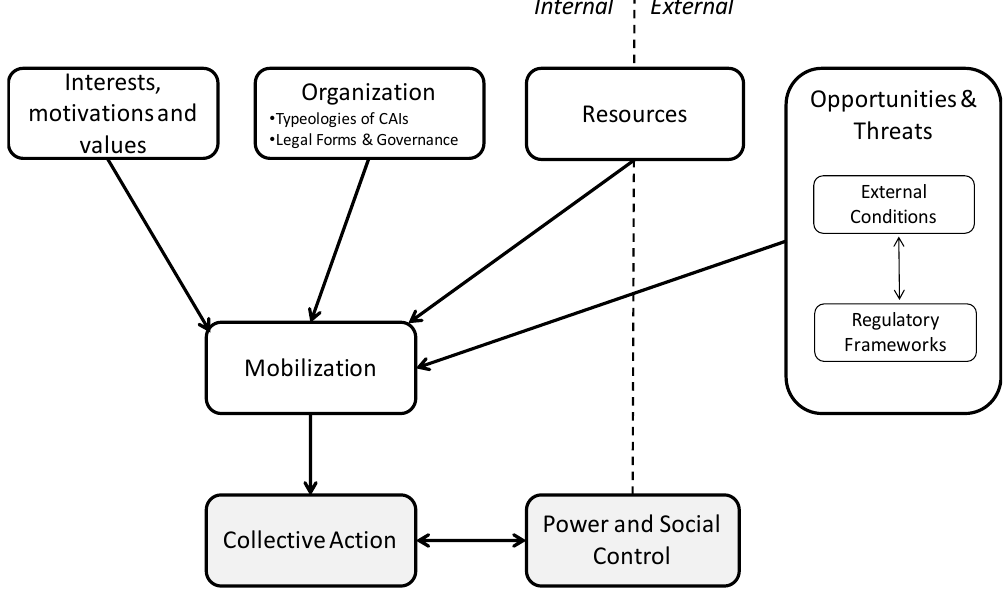
Figure 1. The Mobilization Model, inspired by Tilly [14]. Tilly [14] created a general mobilization model for all forms of collective action from worker strikes to large scale political revolutions. We simplify the model in order to apply it to CAIs in the energy sector. Whereas Tilly [14] describes dimensions of repression and facilitation, we divide this into the two components of external conditions and the regulatory framework, and place this under the opportunities and threats in the external domain. Resources are also not explicitly a component in Tilly’s [14] mobilization model, but are an important factor in energy CAIs and this dimension straddles both internal and external domains. Power is also more narrowly defined here than in Tilly’s [14] model (which can be applied from striking unions to political revolutions). An energy collective seeks only control over its local energy system with the goal of attaining social benefits that come with this action (e.g., stability, cohesion, identity, etc.). Power internal to the CAI influences its external power, and vice versa. The linkages between these are also simplified, though we acknowledge, similar to Tilly [14], that the processes are complicated and secondary and tertiary links are